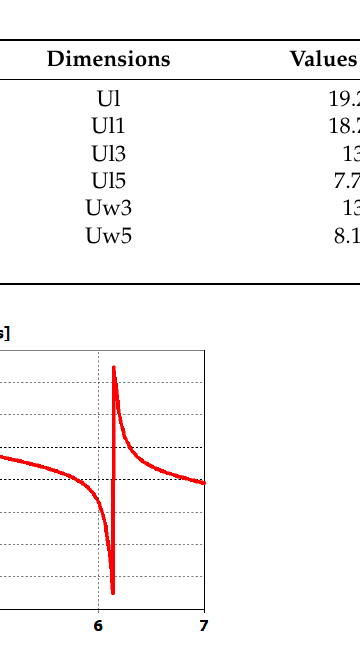
Figure 12. Zero-phase reflection coefficient of the unit cell. Table 3. Dimensions of the unit cell.